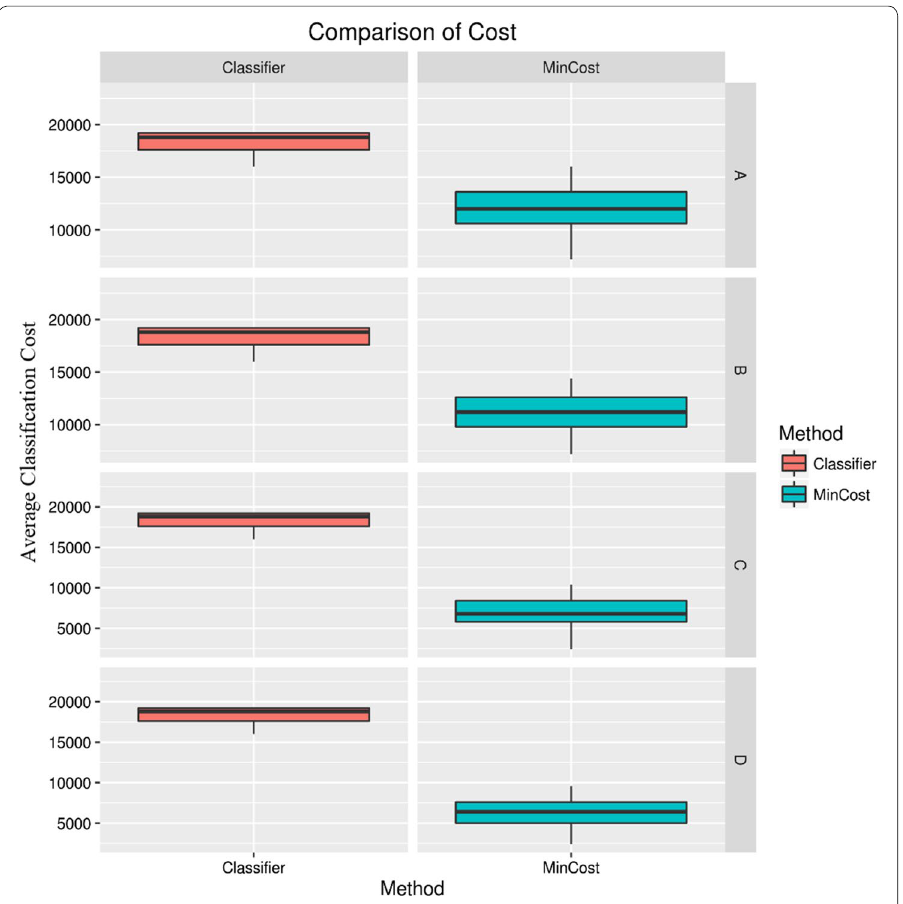
Fig. 6 Comparison of MinCost and binary classification patient cost for each assumption scenario